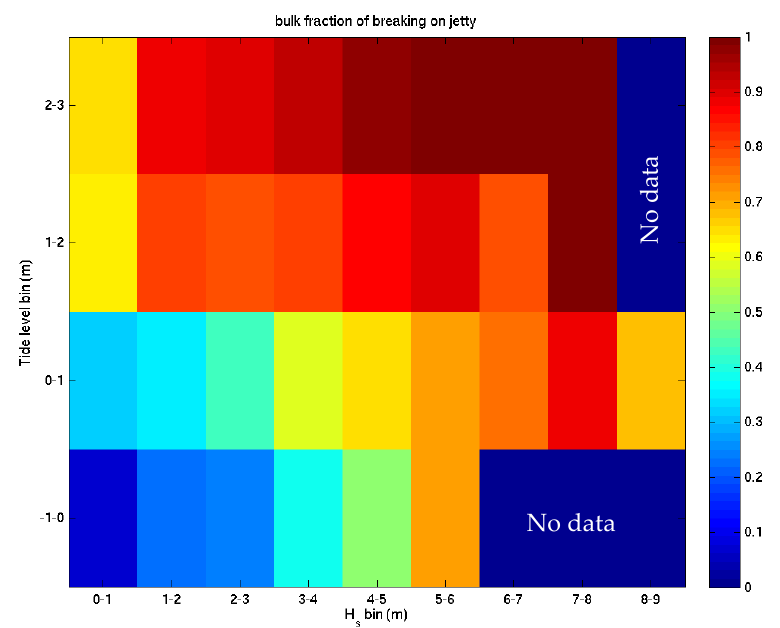
Figure 9. Averaged pan image for the lowest tides and lowest waves (only one image fit this condi- tion). The jetty was manually digitized (dashed blue line) to define the region of interest for breaking detection. This region was then applied to pan images for all tide and wave height bins to detect the fraction that was obscured by breaking waves.